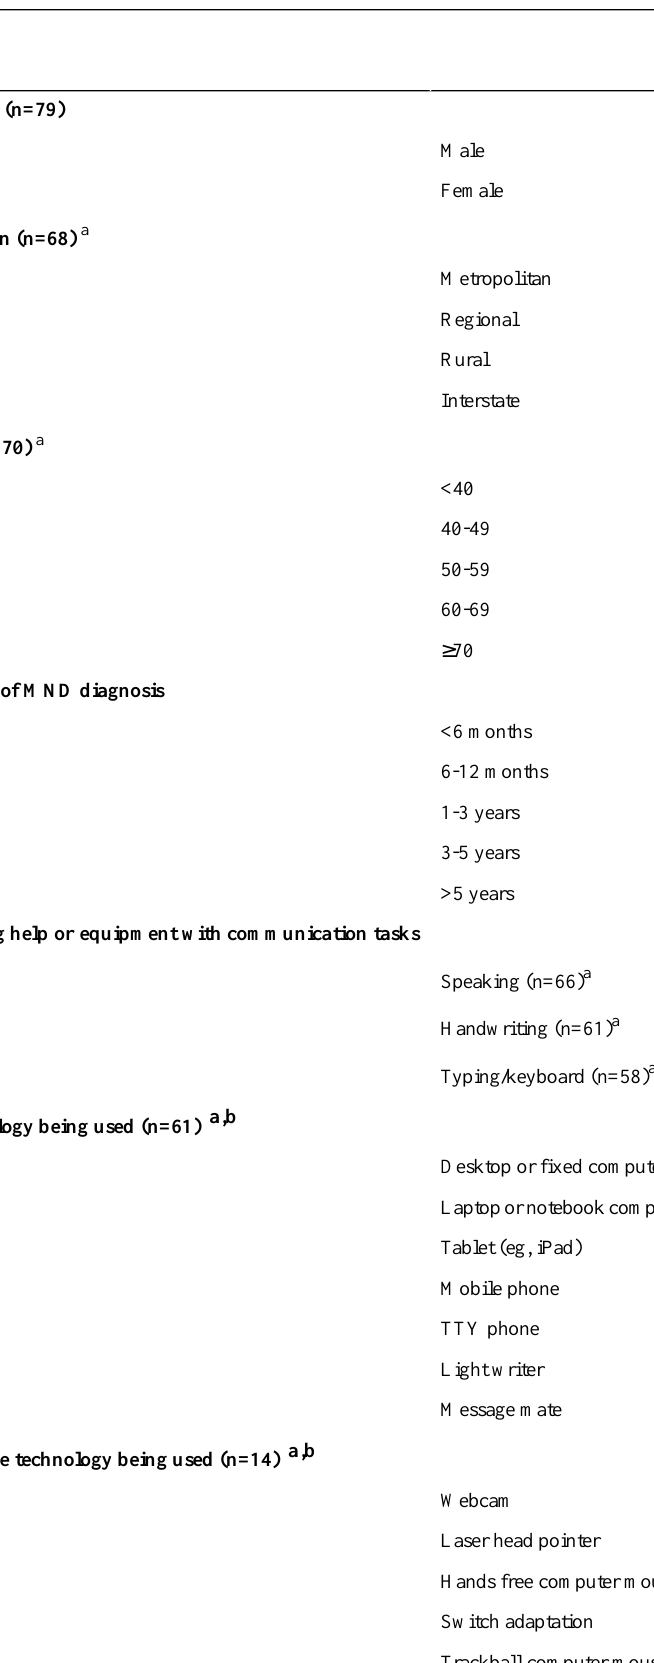
Table 2. Characteristics of survey respondents